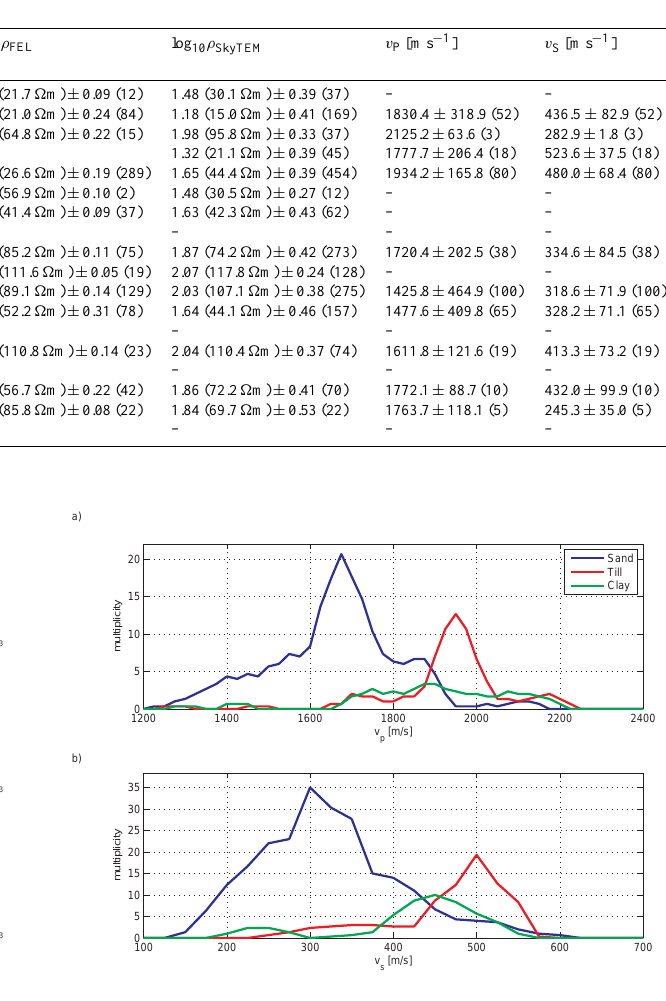
Table 2. Petrographical classification and petrophysical parameters: mean values, standard deviation and number of counts for common logarithm of resistivity and seismic velocities.